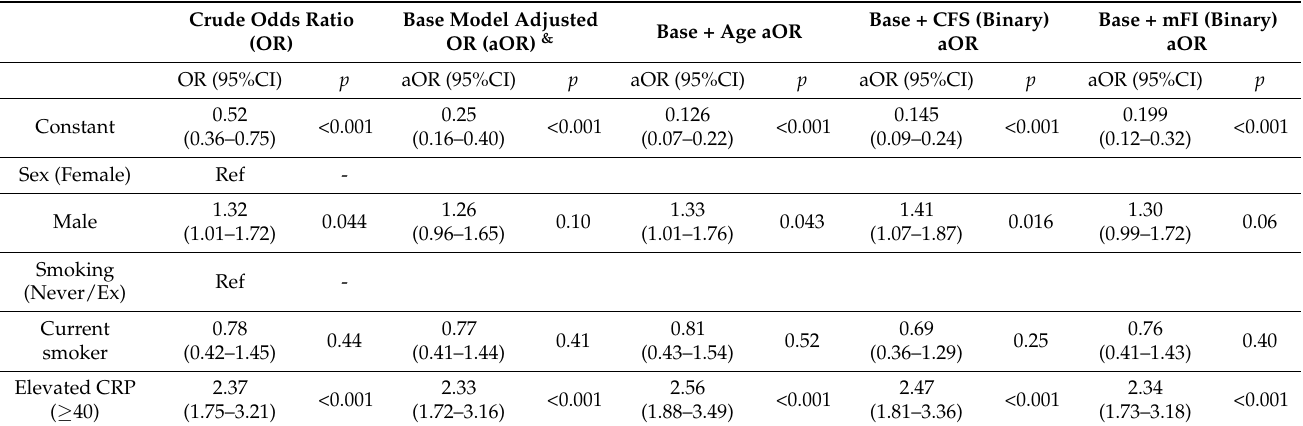
Table 2. Day-28 mortality, mixed effects logistic regression, presenting the Odds ratio (OR) and adjusted OR (aOR) adjusted for the Clinical Frailty Scale (CFS), modified Frailty Index (mFI), and age